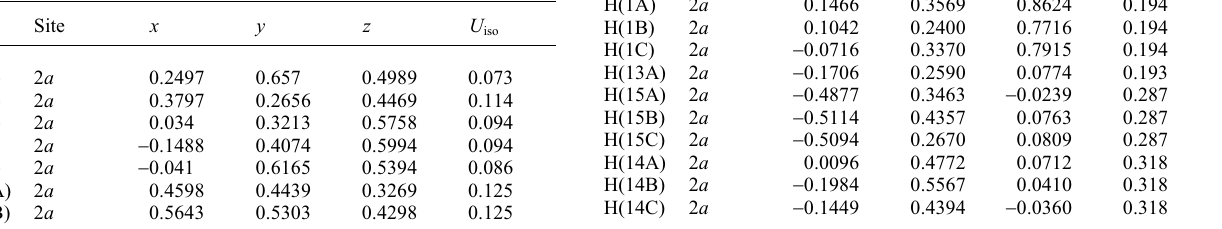
Table 2. Atomic coordinates and displacement parameters (in Å 2 ) .